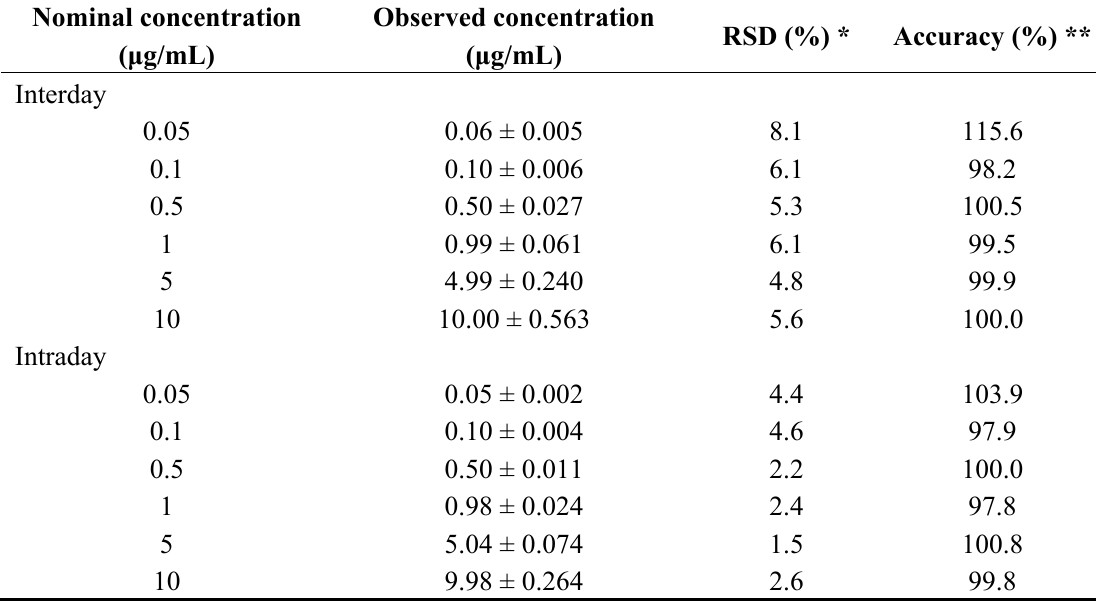
Table 1. Inter-day and intra-day assay of sildenafil in rat